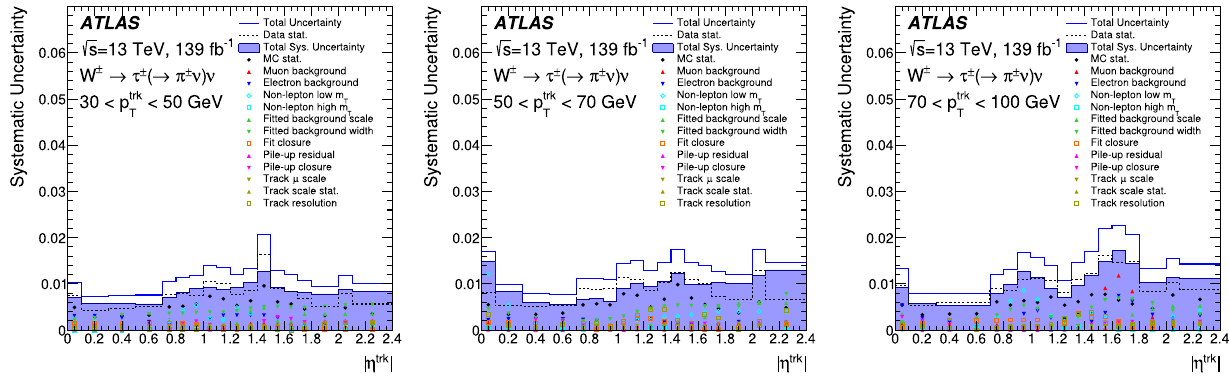
Fig. 4 The various systematic uncertainties which affect the measurement of the calorimeter energy scale for charged pions as a function of p trk in the central (left) and endcap (right) regions